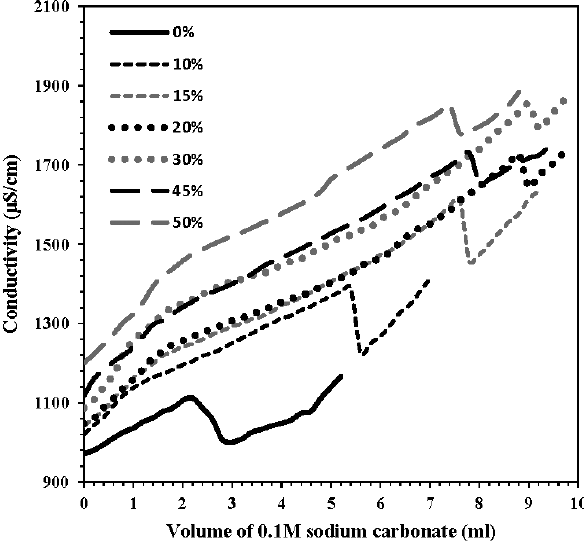
versus the amount of 2